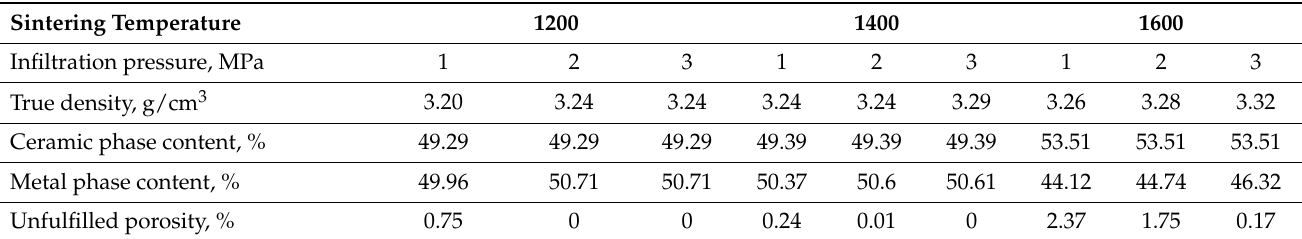
Figure 4. Results of the prosimetry test. Table 2. Results of infiltrated composite density